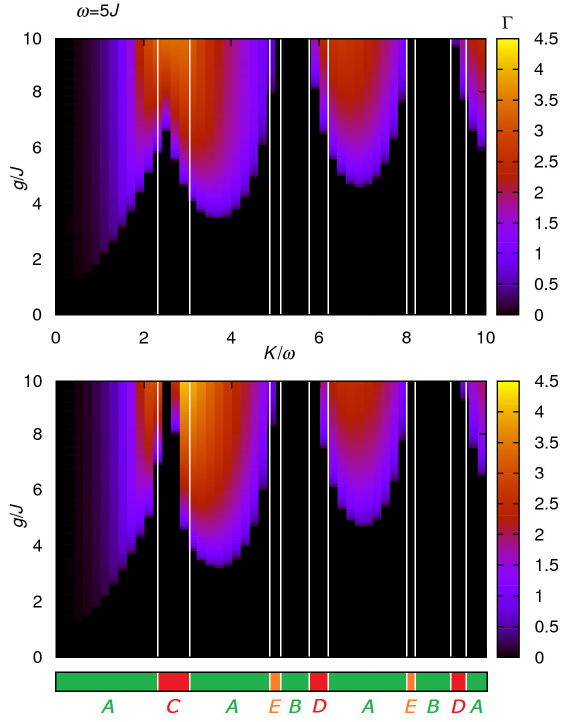
FIG. 2. Numerical (top panel) and analytical (bottom panel) stability diagram for the model described by Eq. (2). The instability rate Γ (expressed in units of the hopping amplitude J , see text) is plotted as a function of the modulation amplitude K= ω [defined in Eq. (2)] and interaction strength g , for a driving frequency ω ¼ 5 J . The vertical lines and letters summarize the agreement and disagreement regions, as dis- cussed in Sec. IV C. A: Away from the zeros of J 0 ð K= ω Þ and J ω Þ , the analytics successfully capture the instability 2 ð K= rates extracted from numerics. B: Agreement zone near the (close) zeros of J 0 ð K= ω Þ and J 2 ð K= ω Þ , where both analytics and numerics predict a stable behavior. C/D: Close to a zero of J ω Þ , the analytical perturbative approach breaks down. 0 ð K= E: Potential quantitative disagreement when the contribution of the second harmonic has a weak amplitude; the instability is then partly due to higher harmonics (see Sec. IV